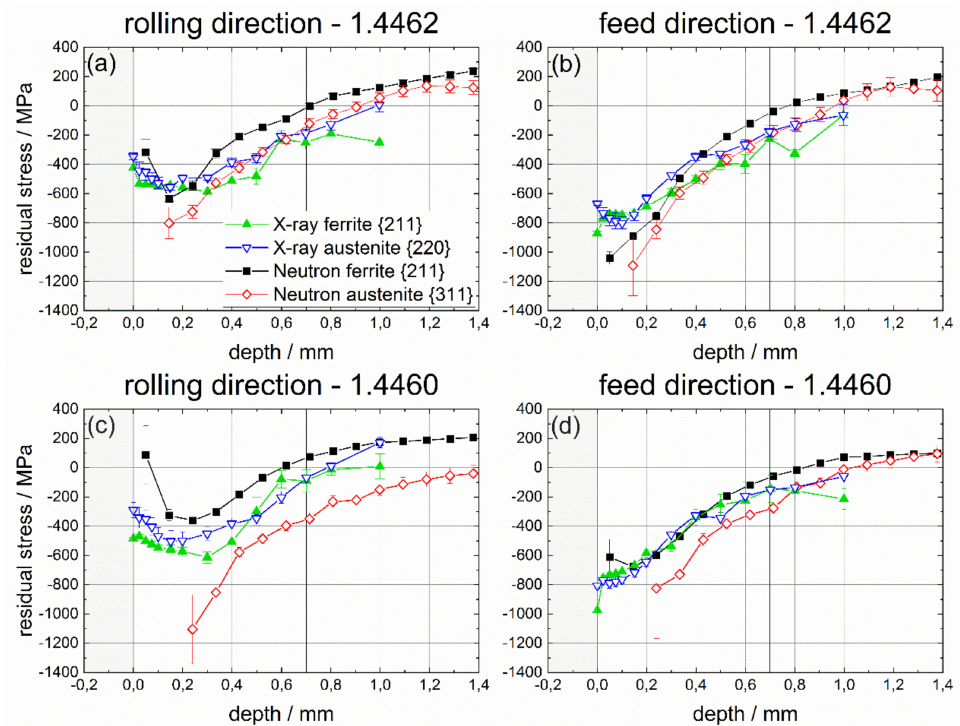
Figure 9. Phase-specific RS for ferrite and austenite determined by means of neutron diffraction and X-ray diffraction in both directions (in the rolling direction (DR) and in the feed direction (FD)) for both materials, i.e., for duplex steel 1.4462 with a phase ratio of 50:50 and for duplex steel 1.4460 with a ferrite to austenite ratio of 70:30.